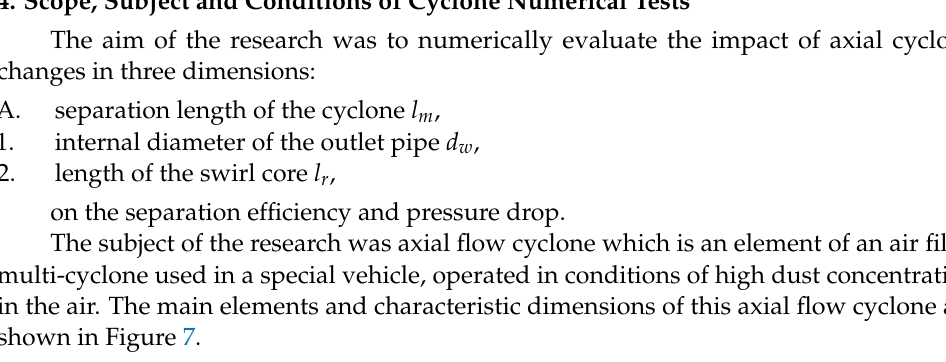
Figure 6. Initial boundary conditions used for flow analysis in axial flow cyclone model.